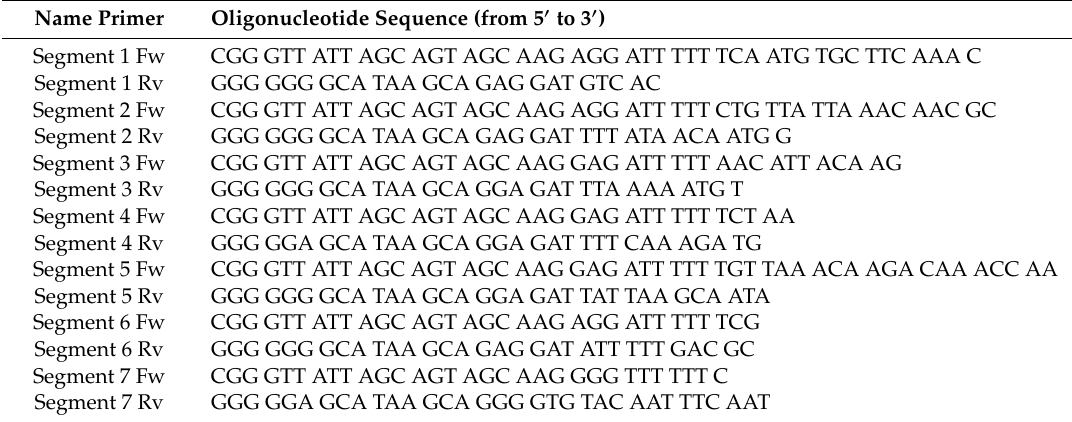
Table 1. Primer sequences for individual gene segment amplification of Influenza D virus